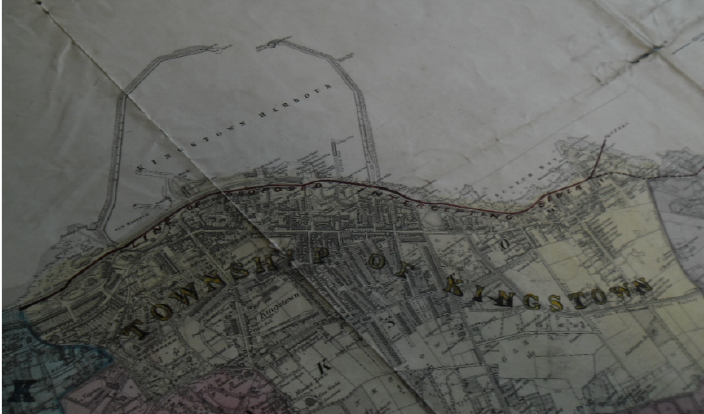
Figure 6. Map fragment, 2015 [1873]. © Silvia Loeffler, Glas Journal,